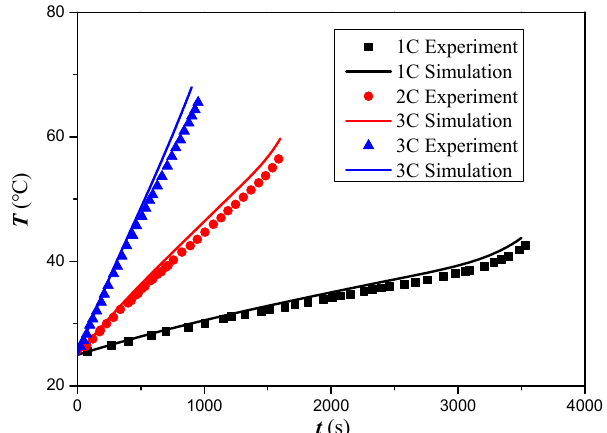
Figure 6. The comparison of the change in the average battery temperature between the simulation results and the experimental measurement taken by Li [50].